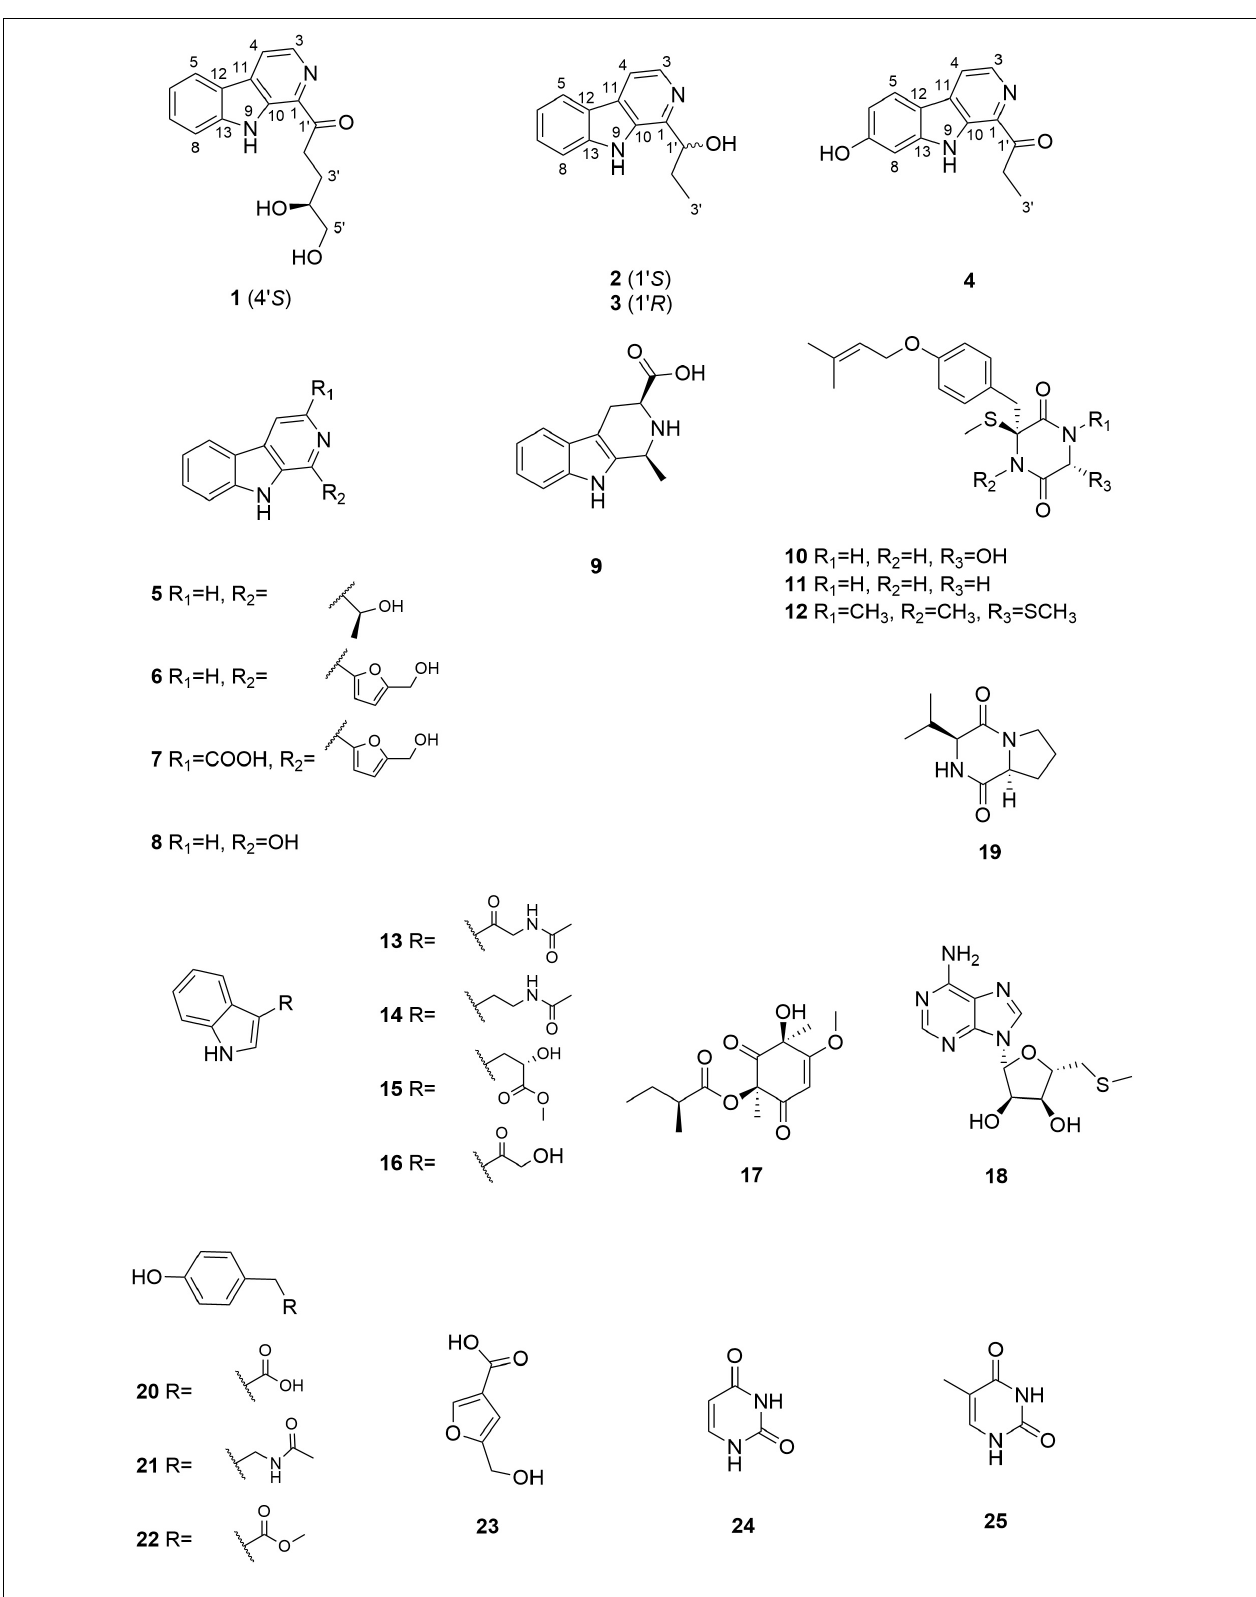
FIGURE 1 | Chemical structures of compounds 1 – 25